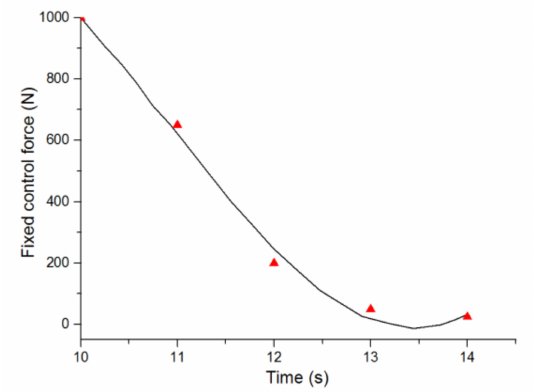
Figure 20. Control force fitting curve for 10 s ≤ t ≤ 14